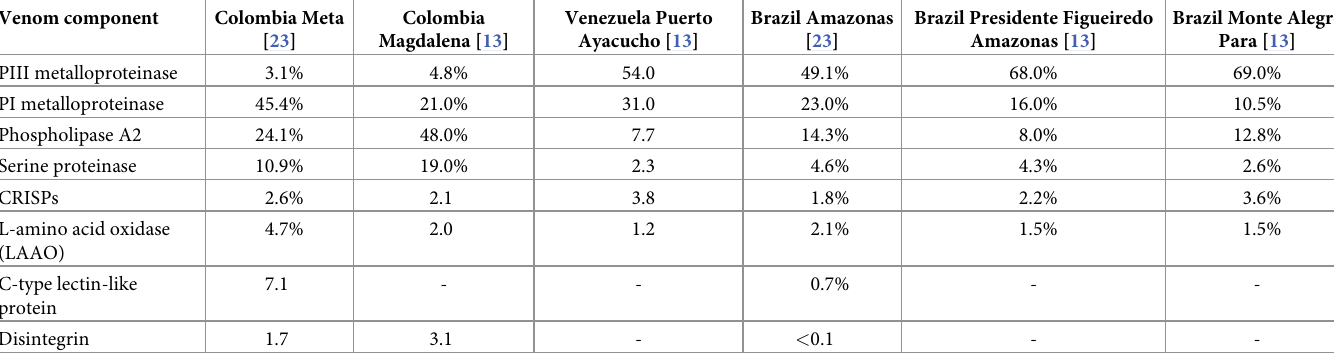
Table 1. Relative abundance of different protein families in the venom proteomes of some populations of B . atrox (data from [13,23]). Venom